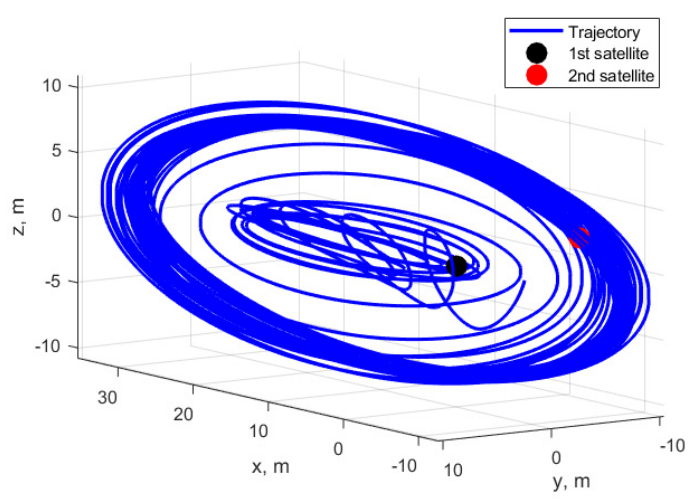
Figure 4. Relative trajectory under control.